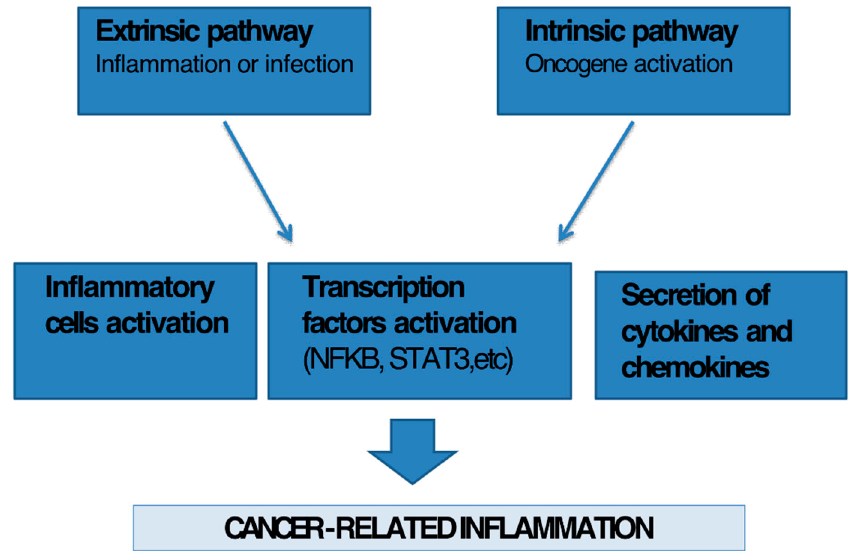
Figure 2. Link between inflammation and cancer. There are two pathways that link inflammation and cancer: extrinsic and intrinsic. The first is activated by inflammatory stimuli, the second by genetic alterations. These pathways are interconnected by the secretion of inflammatory cytokines that activate specific transcription factors (NFKB, STAT3, etc.) and lead to the secretion of inflammatory mediators including growth factors, metalloproteases that contribute to the development of inflammatory tumor microenvironment.